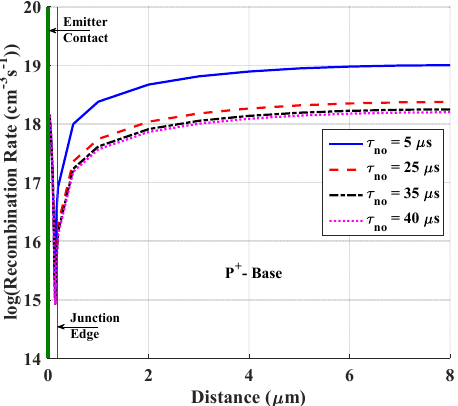
Figure 8. Recombination rate along the lateral distance of the flipped npn structure for different values of base lifetime.